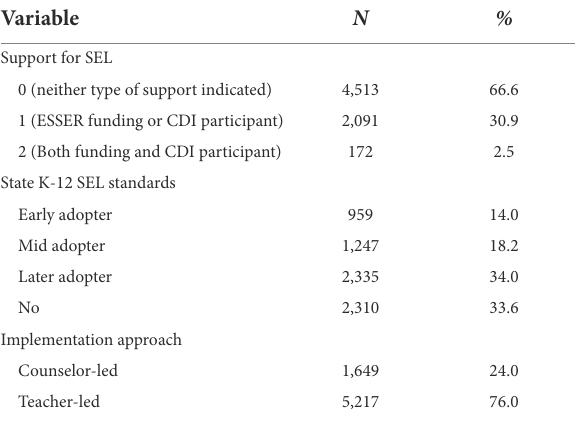
TABLE 2 Descriptive statistics for predictor variables and criterion